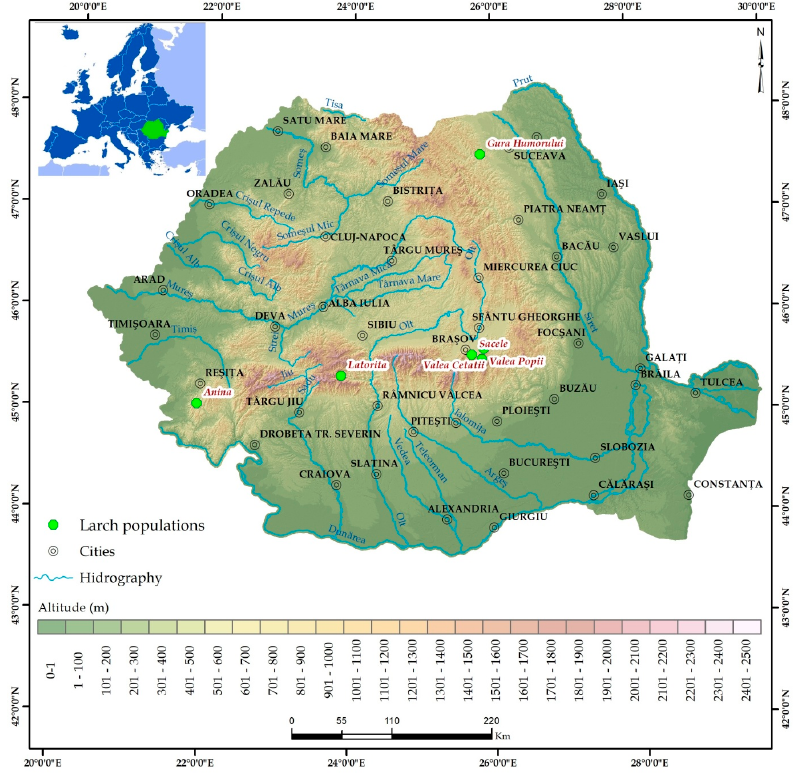
Figure 1. Origin of the European larch seeds used to obtain the seedlings.